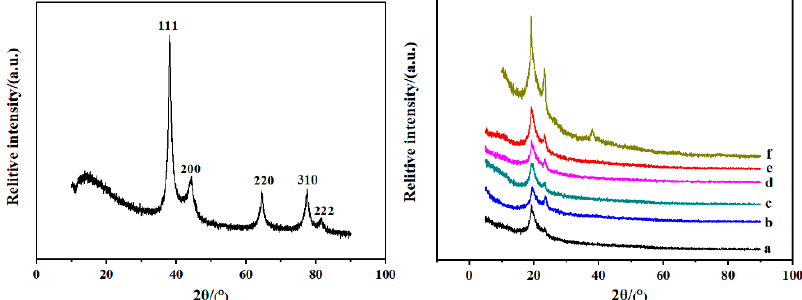
Figure 7. XRD patterns of the as-synthesized AgNPs ( left ) and FK/PVA/PEO composite nanofibers ( right ): ( a ) 0%-AgNPs, ( b ) 0.6%-AgNPs, ( c ) 1.2%-AgNPs, ( d ) 1.8%-AgNPs, ( e ) 2.4%-AgNPs, ( f ) 3%-AgNPs.